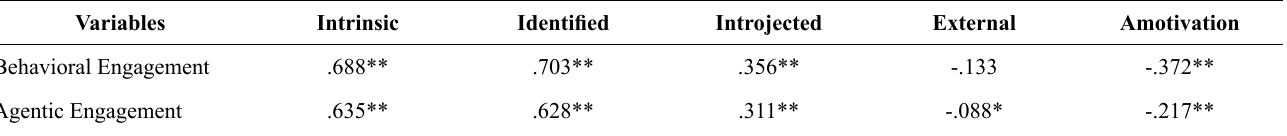
Table 5 Nomological